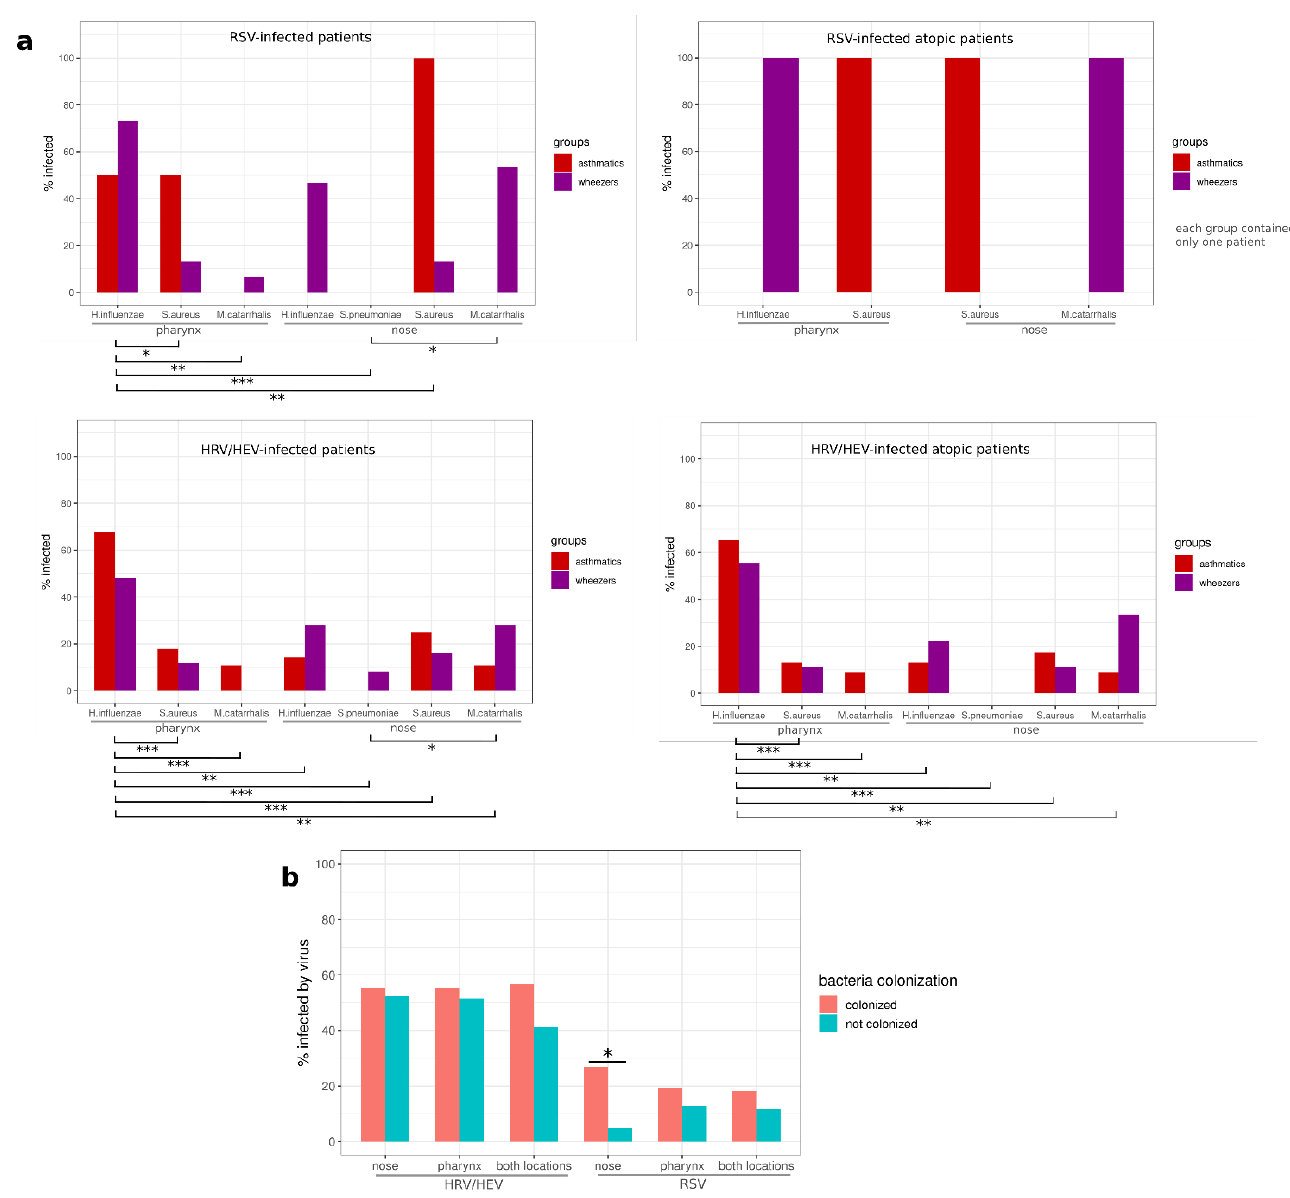
Figure 5. Bacterial profiles in patients with human rhinovirus (HRV) or respiratory syncytial virus (RSV) infections ( a , b ). In each cohort subset, we compared bacteria colonization between groups for each selected bacteria and location and between bacteria and location with all groups combined. We used chi-square tests of independence and corrected all p -values using the FDR method. Pairwise comparisons were conducted using Fisher’s exact test ( Haemophilus influenzae = Haemophilus influenzae + Haemophilus parainfluenzae, S. aureus = Staphylococcus aureus, S. pneumonia = Streptococcus pneumonia, M. catarrhalis = Moraxella catarrhalis). * p < 0.05; ** p < 0.01; *** p < 0.001.